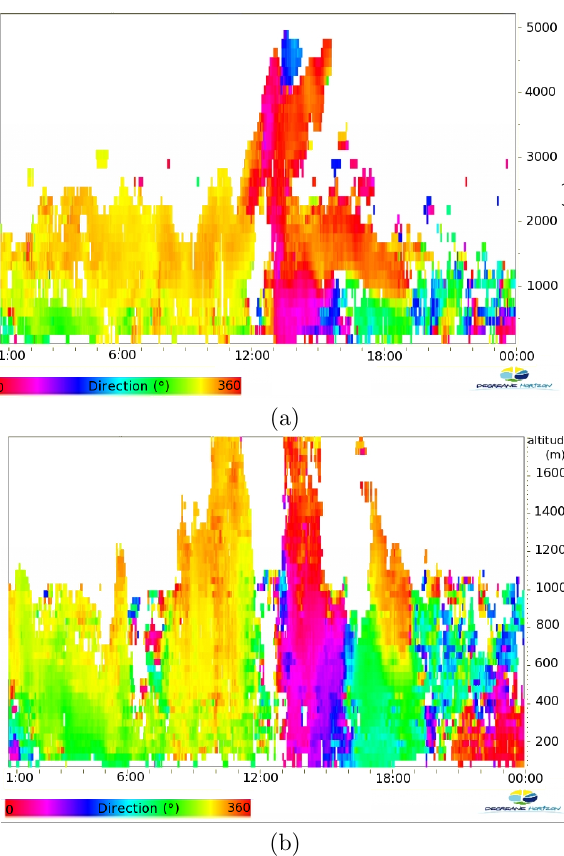
Fig. 4. Vertical wind directions observed every 2min by the wind profiler located at the west of the runways for the 24 March 2009 for the low vertical resolution (a) and for the high vertical resolu- tion (b) . Graphs obtained with the Degreane-Horizon signal pro- cessing software.